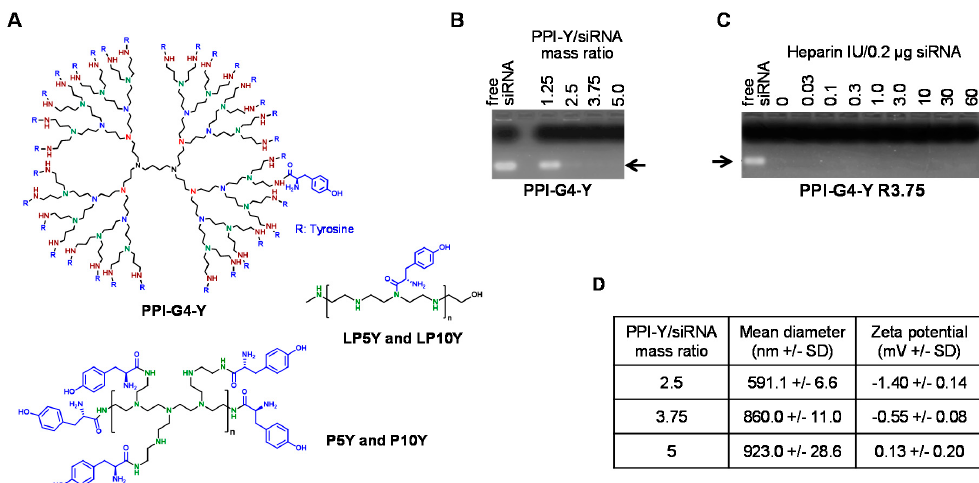
Figure 1. ( A ) Structures of tyrosine-modified PPI-G4 (“PPI-G4-Y”; upper panel) as well as tyrosine-grafted branched or linear polyethylenimines (PEIs) (lower panels; numbers indicate molecular weights of PEI). ( B ) Analysis of PPI-G4-Y-mediated siRNA complexation e ffi cacy, dependent polymer/siRNA mass ratios. ( C ) Determination of PPI-G4-Y/siRNA complex stability by heparin